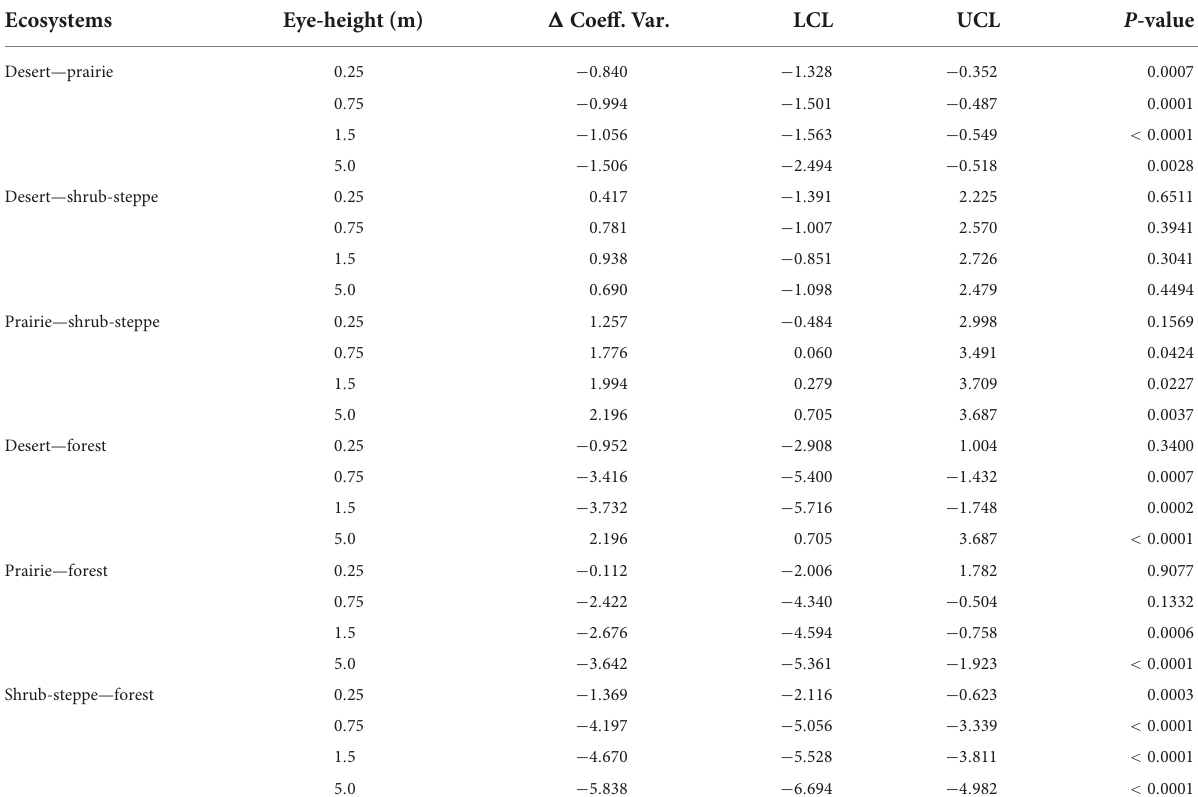
TABLE 3 Coefficients of variation across ecosystems. Ecosystems Eye-height (m) (cid:49) Coeff. Var. LCL P